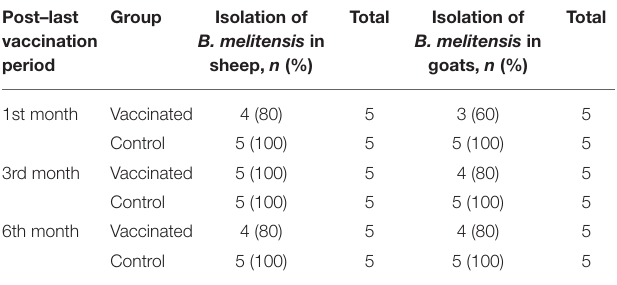
TABLE 1 | Rates of infection in the sheep and goats after challenge with the virulent strain Brucella melitensis